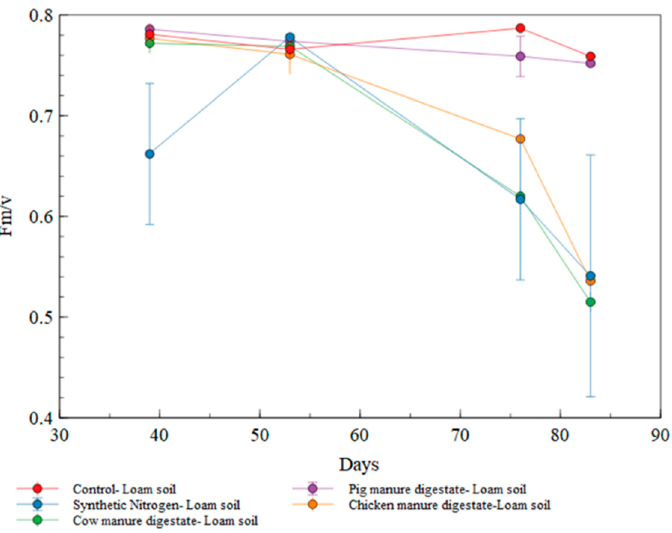
Figure 8. Florescence measurement for all treatments in loam soil.